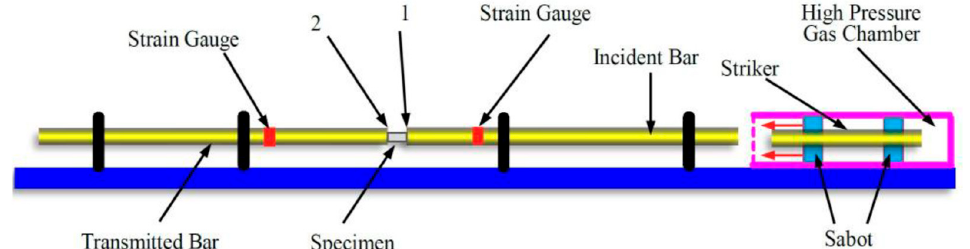
Figure 6. The structural device diagram of SHPB pressure bar.